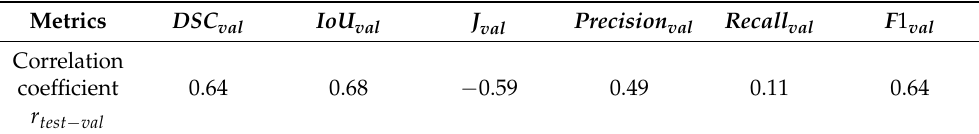
Table 1. Correlation between DSC test and validation metrics for the U-Net model with a ResNet152